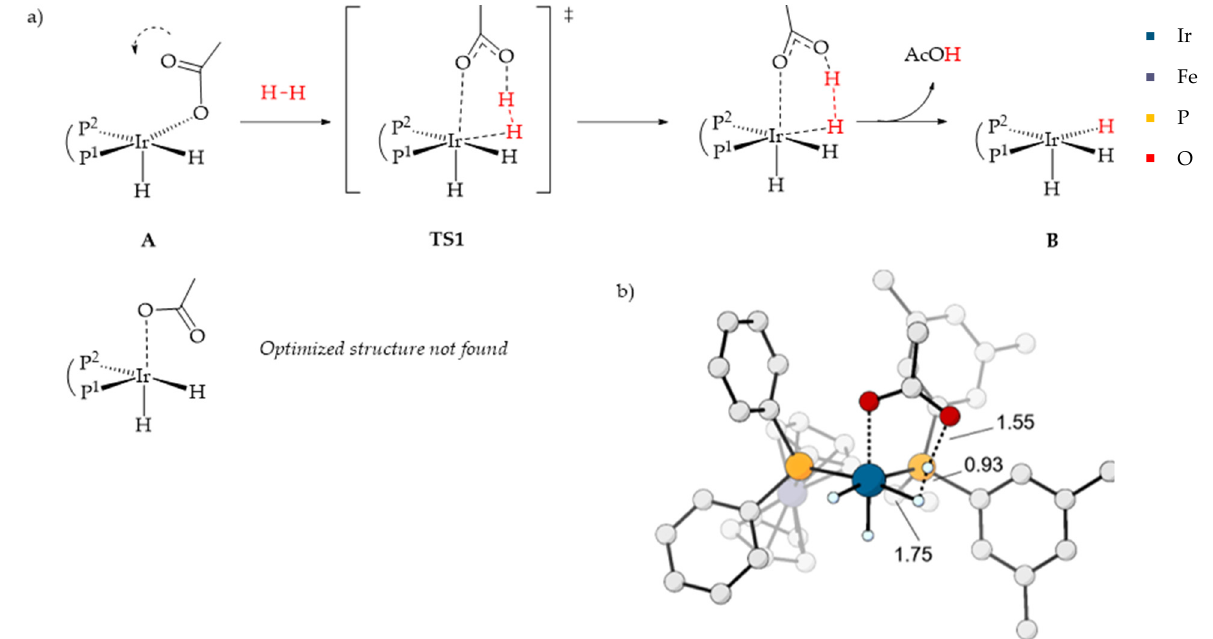
Figure 6. ( a ) “Catcher’s mitt” mechanism by iridium-bound acetate, which “catches” the proton from heterolytic splitting of H 2 . ( b ) Structure of TS1 with relevant atomic distances reported in Å. C-H hydrogens were omitted for clarity.